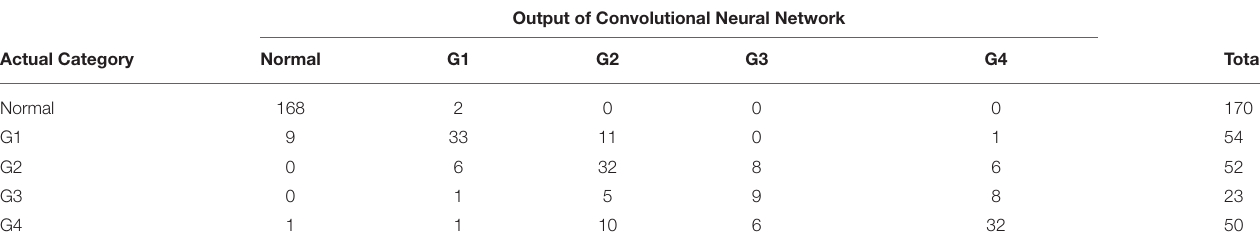
TABLE 2 | The output data for test sets of deep learning in the grade classification according to the Amsler-Krumeich classification. Output of Convolutional Neural Network